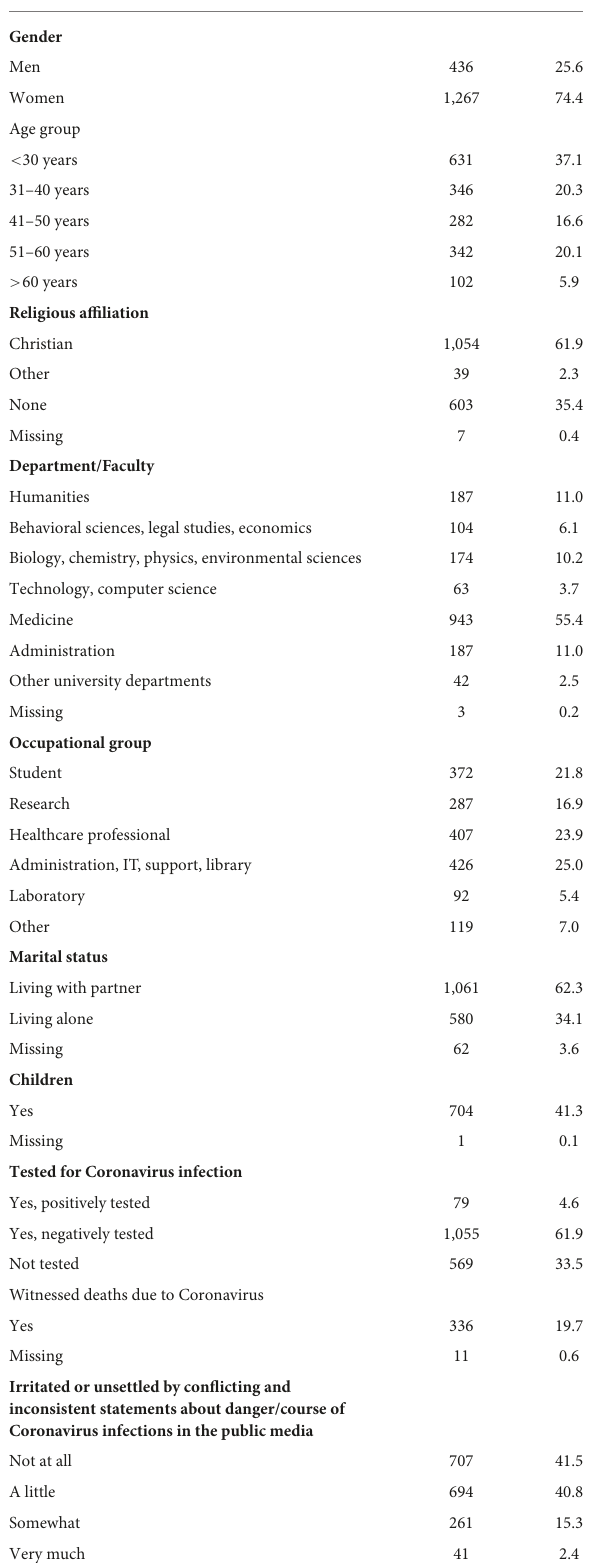
TABLE 1 Socio-demographic information ( n =